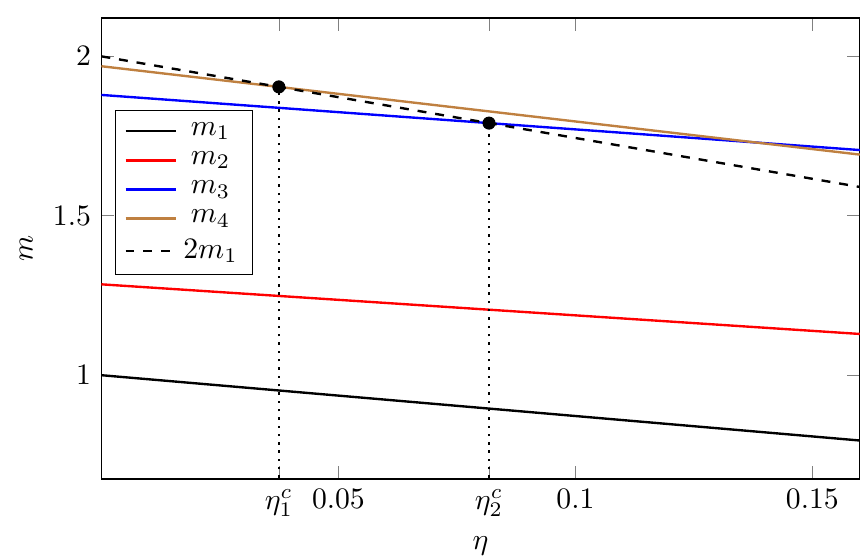
Figure 4.2: Evolution of the mass of particles A line corresponds to the threshold line to the continuum. The critical values η c are those where the mass of the particles A